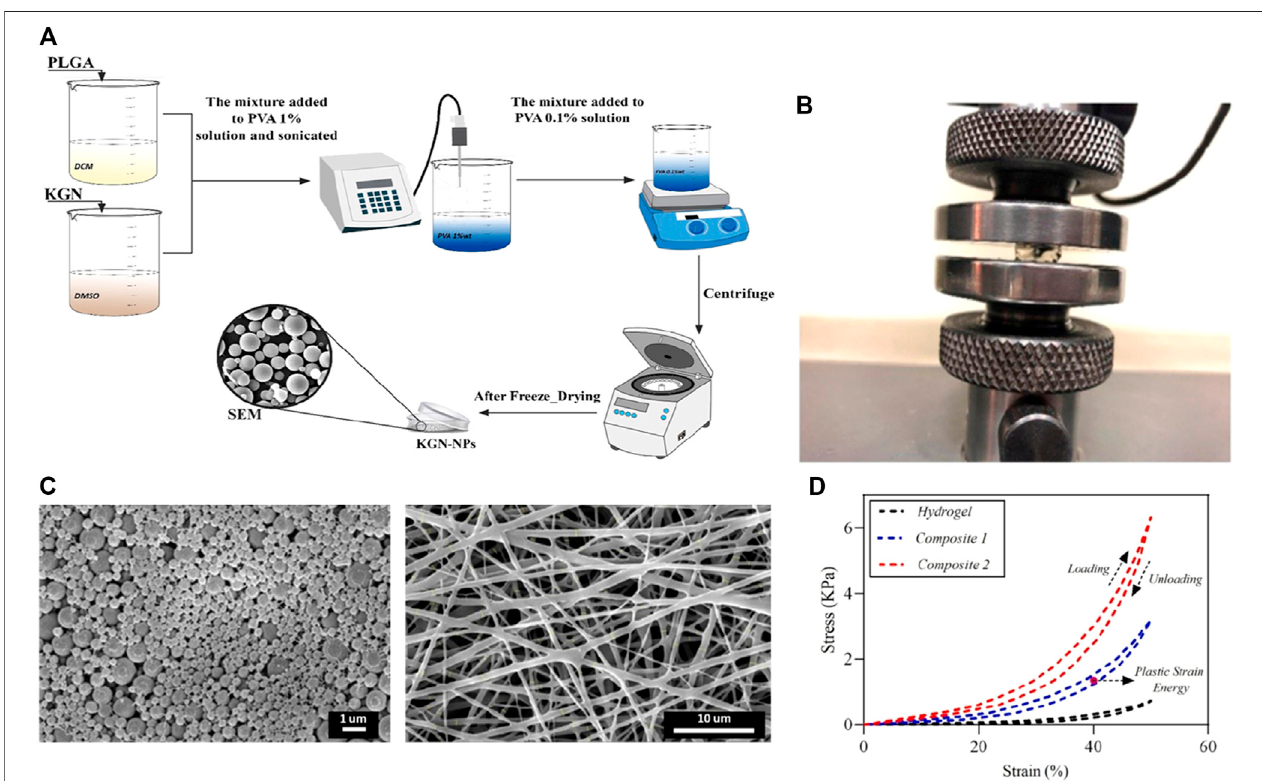
FIGURE4|(A) SchematicillustrationofthesynthesisofKGN-PLGAnanoparticles; (B) Themechanicaltestoffabricatedsamples; (C) TheFESEMimagesofKGN- PLGA nanoparticles and Gelatin electrospun mat; (D) The results of hysteresis loop at 50% strain. Reproduced from Zare et al. (2021) with permission from Copyright 2021